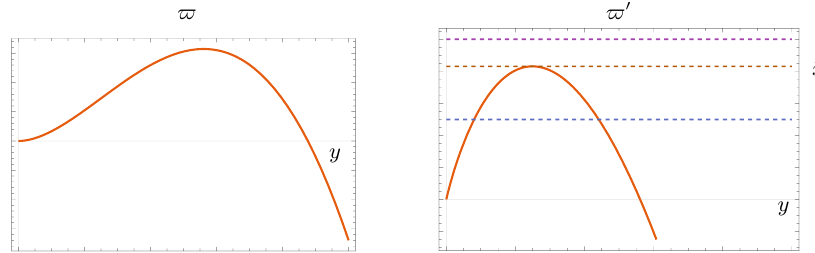
Figure 2 . The function $ ( y ) (left) and its first derivative $ 0 ( y ) (right) on flat space (the torus). The function $ ( y ) has a flex at y = ¯ y that separates a convex region for y < ¯ y from a concave one. The maximization condition x = $ 0 ( y ) admits two solutions for x < ¯ x = $ 0 (¯ y ) and no real solutions for x > ¯ x ; the physical branch corresponds to the first intersection (right).